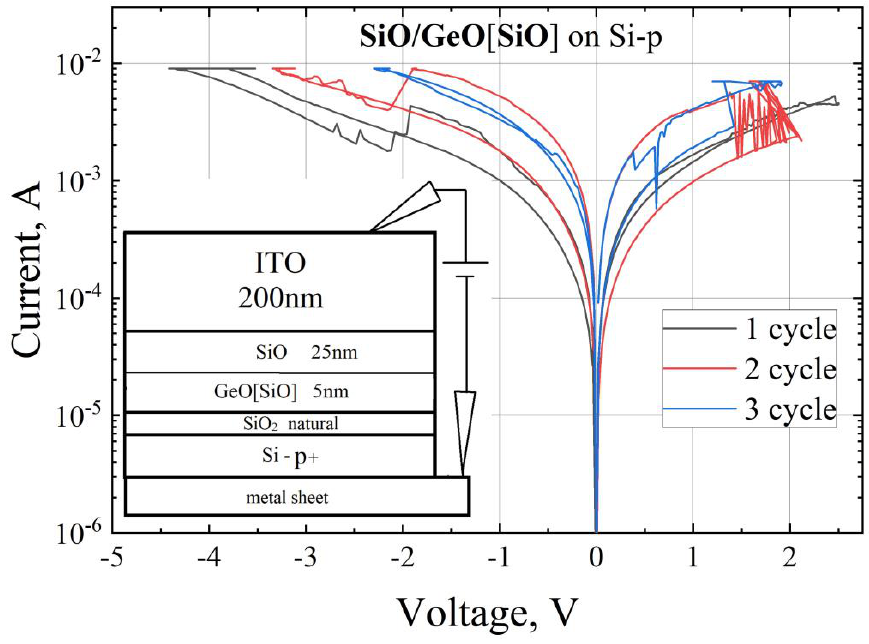
Figure 8. I – V curves of the sample B. Figure 8. I–V curves of the sample